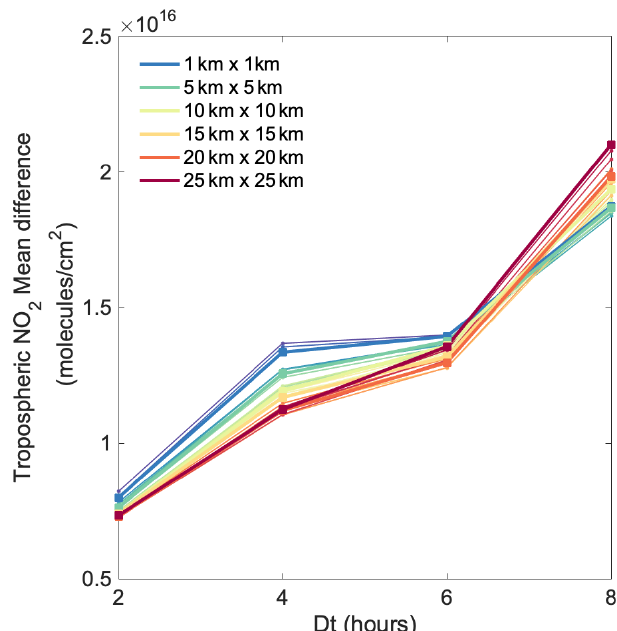
Figure 6. Temporal mean differences (TeMDs) of hypothetical satellite pixels (molec.cm − 2 ) over the Seoul Metropolitan Area as a function of time difference (Dt). Results for each pixel size are color coded, with selected sizes shown with thicker lines for refer- ence. See also text for